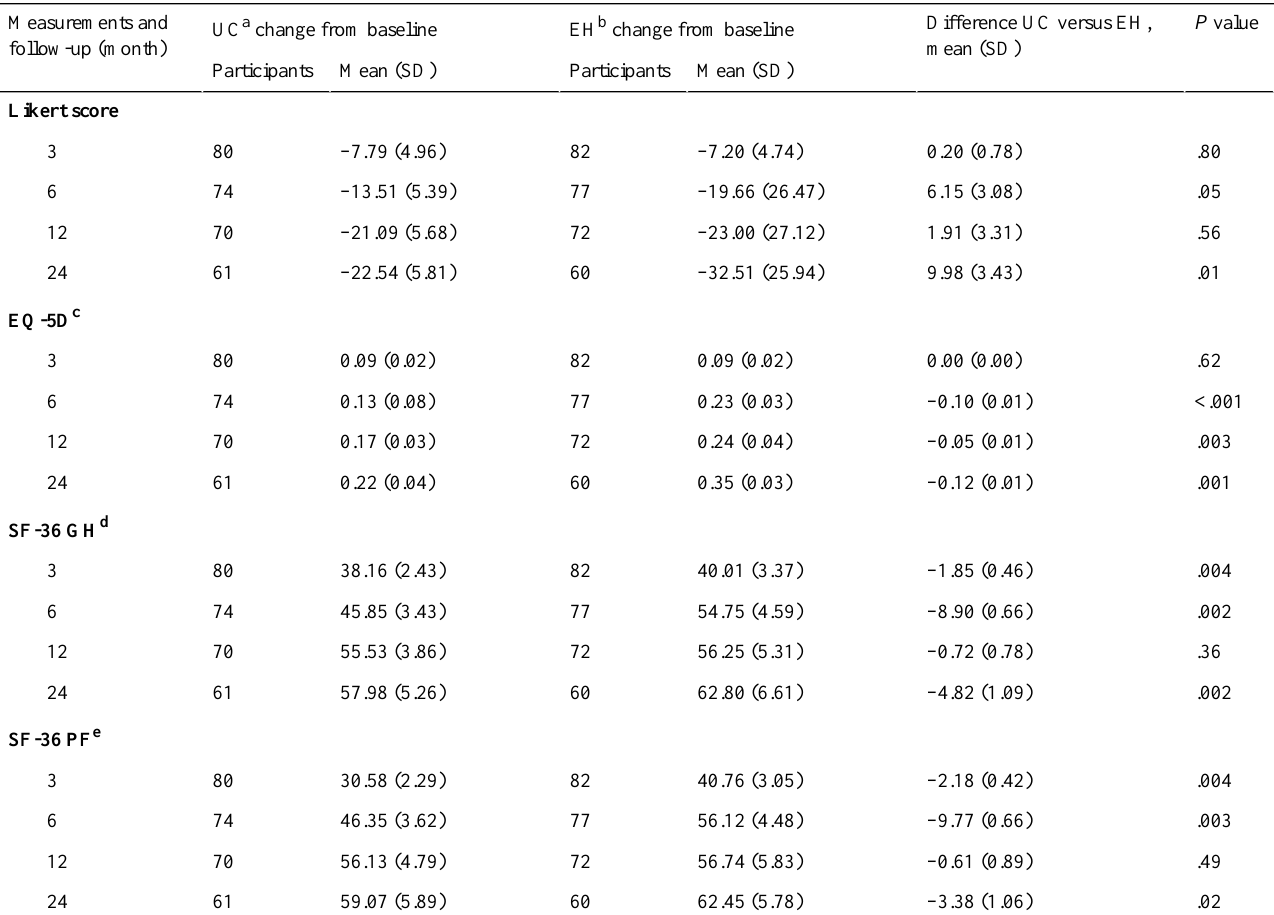
Table 4. Secondary outcomes change from baseline and between-group difference outcomes.